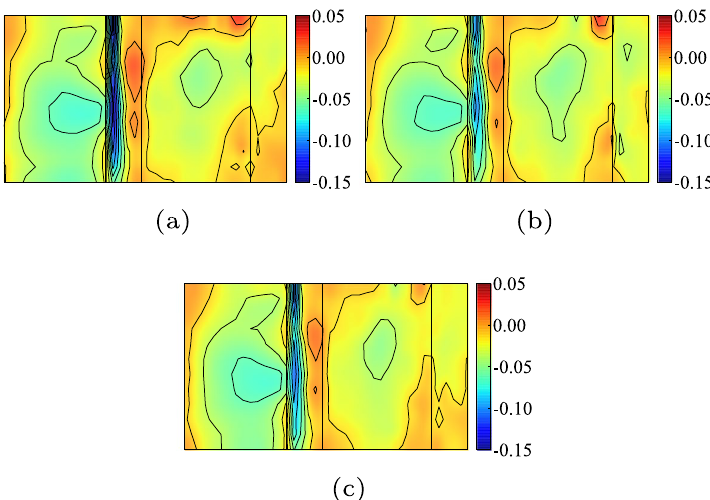
Fig. 15 The surface distributions of the PE C ′